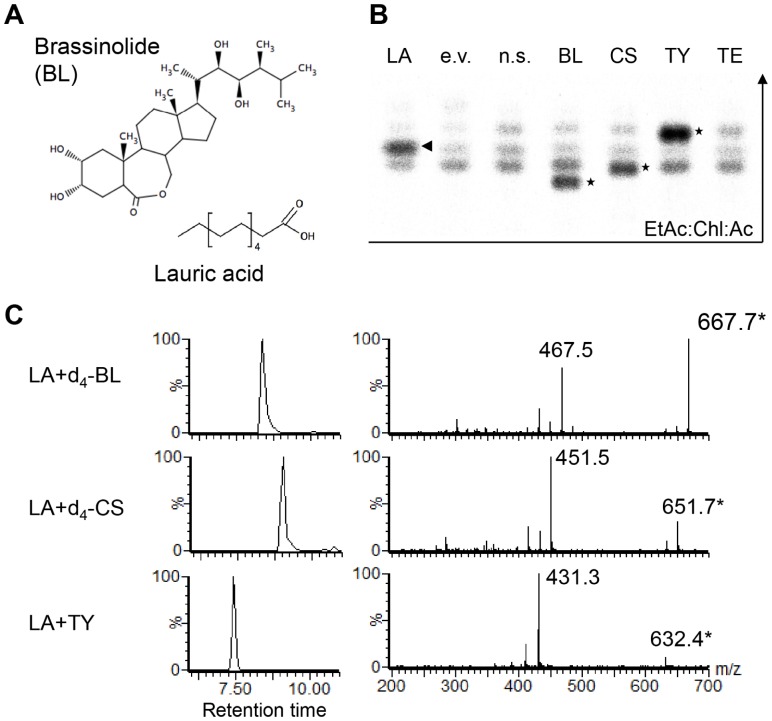
PIZ Converts BRs to the corresponding acylated products in vitro.(A) Structures of BL and 14C-lauric acid-CoA (LA-CoA). (B) Detection of 14C-labeled products extracted with ethyl acetate and separated by silica-gel thin layer chromatography. An asterisk marks the respective specific product for the applied substrates, BL, CS and TY, after 2 h of reaction at room temperature. An arrowhead marks free lauric acid (LA). e.v., empty vector control, n.s., no BR substrates. (C) LC-MS/MS analysis of the acylated products. Products were extracted from silica-gel after TLC and analysed on LC-MS/MS. Enzyme reactions were carried out using non-labelled LA and d4-BL, d4-CS or non-labelled TY. Predicted pseudo-molecular ions ([M+H]+) for the acylated products are shown with an asterisk.